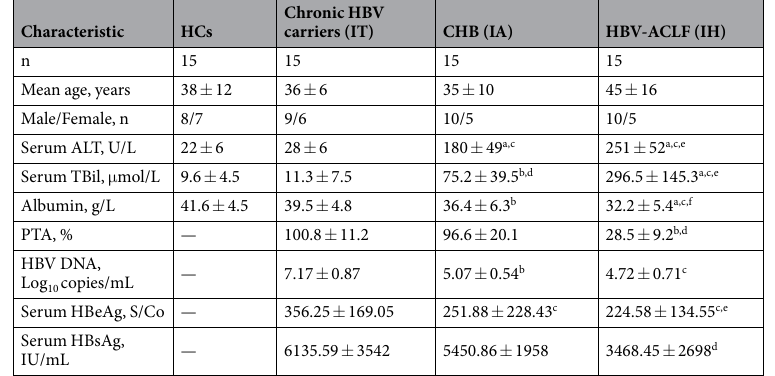
Table 1. Demographic and clinical characteristics of all recruited subjects in this study (Mean ± SD). ALT, alanine aminotransferase; TBil, serum total bilirubin; PTA, prothrombinase activity; HBV hepatitis B virus; HCs, healthy controls; chronic HBV carriers (IT); CHB, chronic hepatitis B (IA); HBV-ACLF, HBV-related acute-on-chronic liver failure (IH). Compared with HCs group, a P < 0.01, b P < 0.05; Compared with ITgroup, c P < 0.01, d P < 0.05; Compared with IAgroup, e P < 0.01, f P <